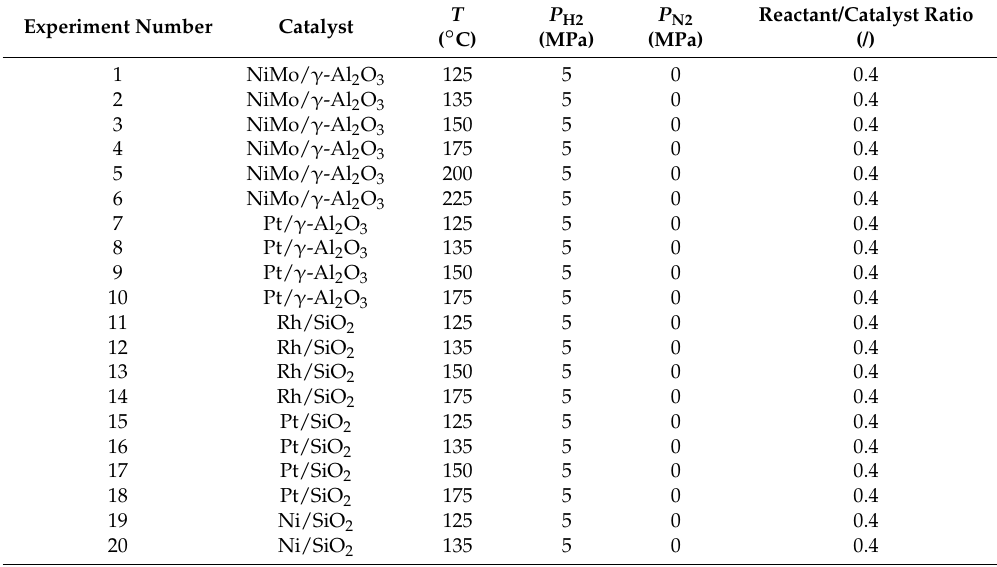
Table 4. List of experiments using mucic acid as a reactant, dissolved in distilled water. Experiments were performed under high pressure of inert gas (N 2 ) or hydrogen (H 2